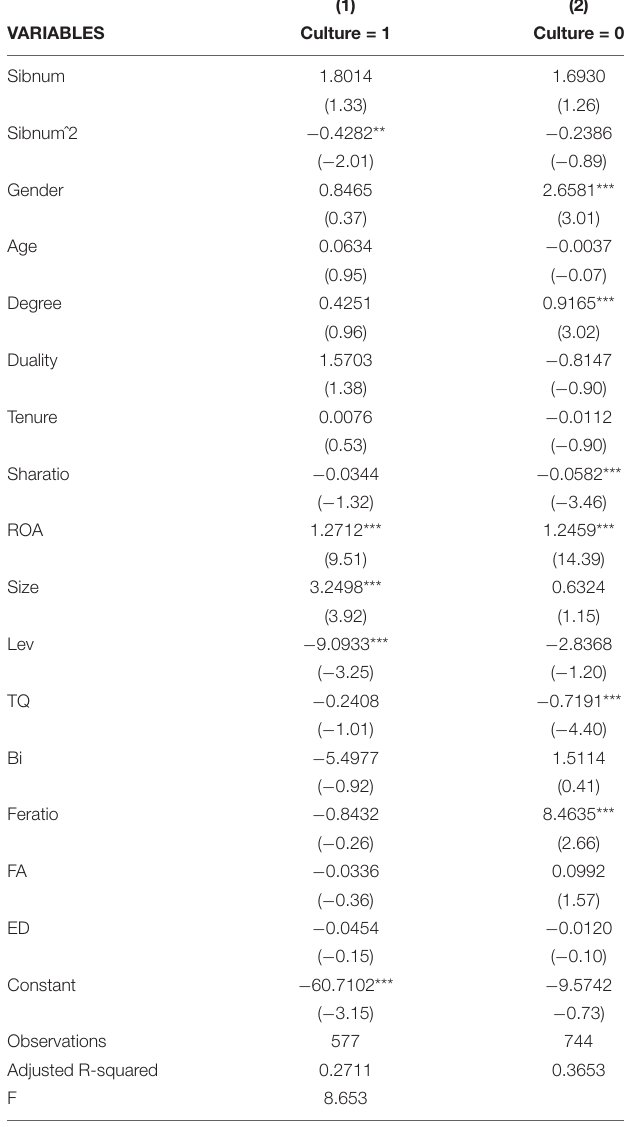
TABLE 10 | The influence of Chinese Confucian